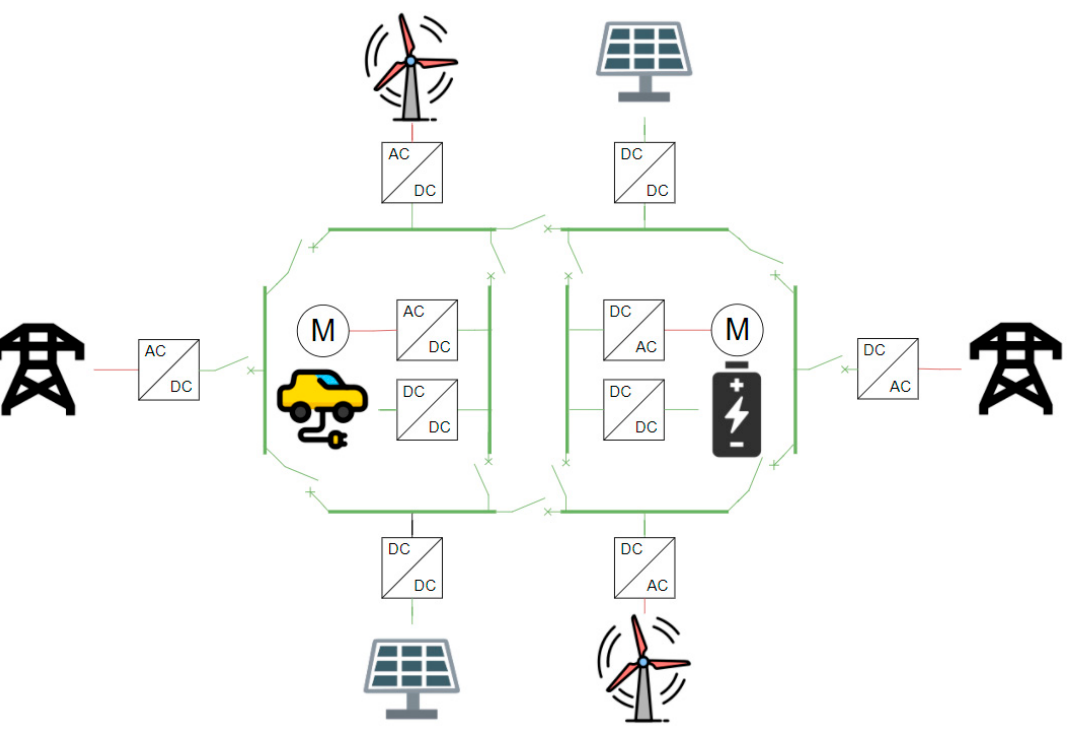
Figure 8. Zonal configuration.